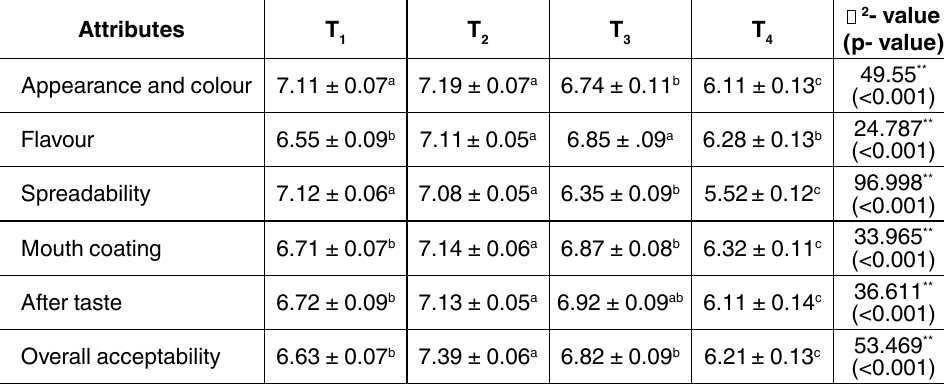
Table 3 . Effect of different levels of mayonnaise and spent chicken on the sensory attributes of chicken meat spread